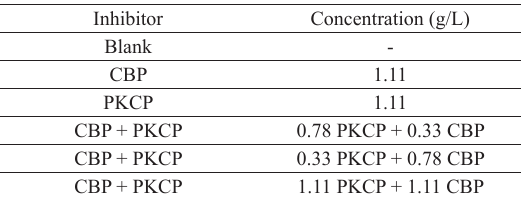
Figure 2. FTIR spectrum of